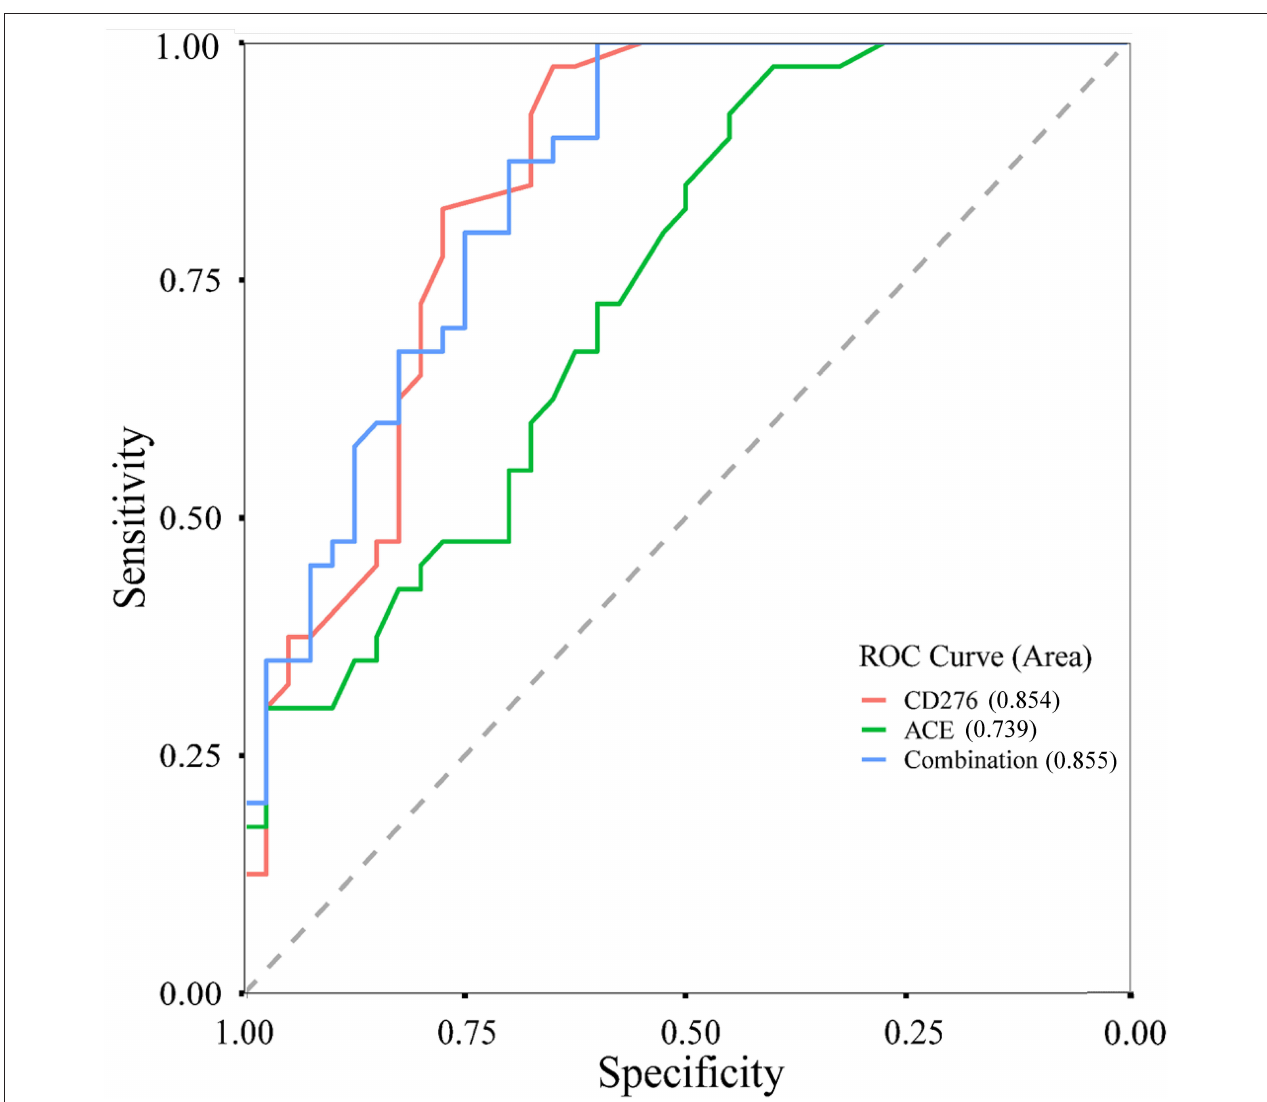
FIGURE 5 | ROC curves of CD276, ACE and their combined levels in children with MPP and healthy controls. ROC, receiver operating characteristic; MPP, Mycoplasma pneumoniae Pneumonia.